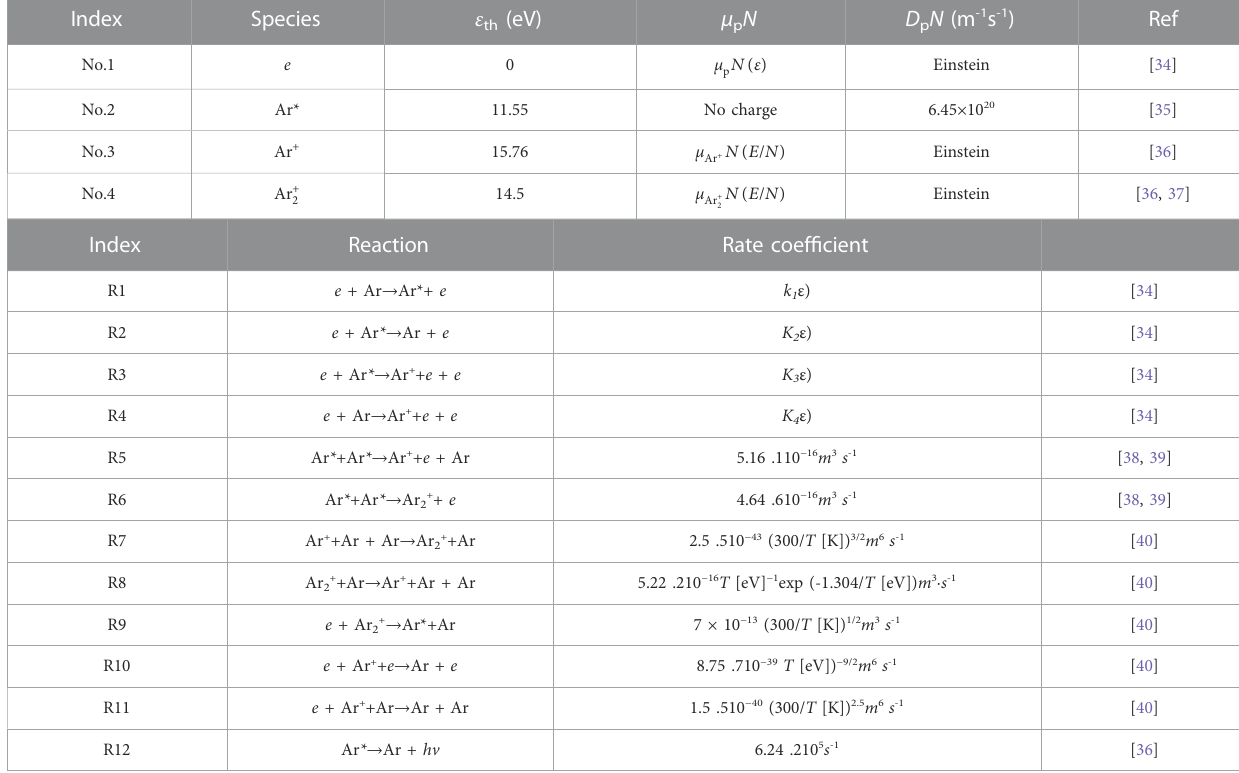
TABLE 1 Transport coef fi cients and associated